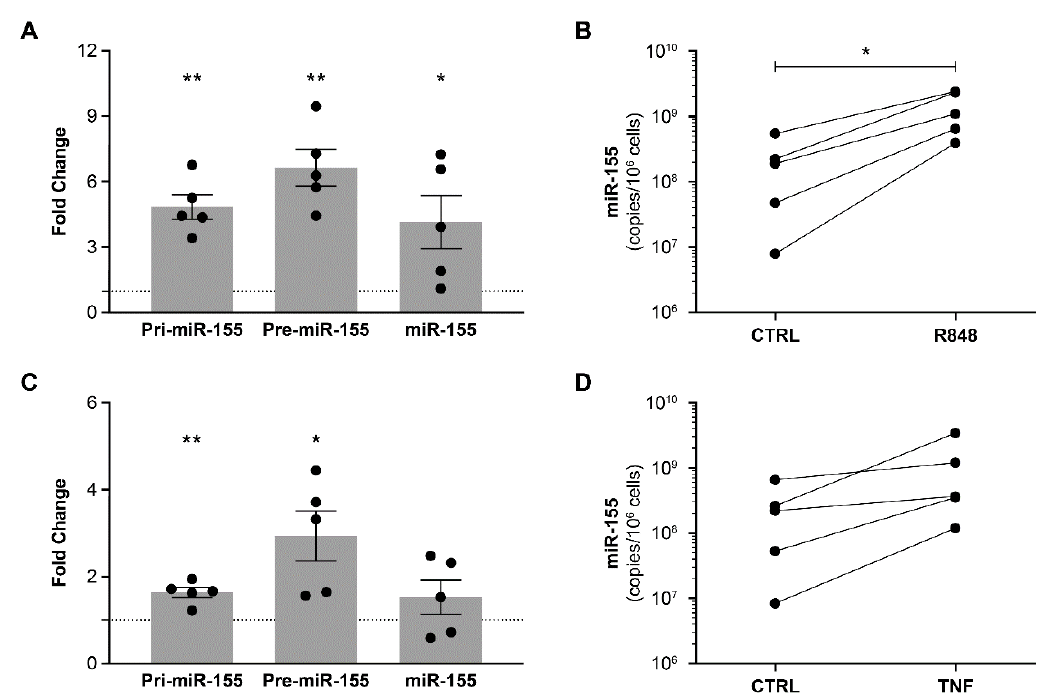
Figure 2. TLR7/8-agonist and TNF increase miR-155 expression in PBMCs. PBMCs freshly isolated from HIV-negative donors (n = 5) were incubated with ( A , B ) R848 (1 µ g/mL) and ( C , D ) TNF (100 ng/mL) for 24 h. For the fold change graphs, pri-miR-155, pre-miR-155, and miR-155 expressions by activated PBMCs are compared to their respective expression in control PBMCs, the latter represented by the dotted line in the graph positioned at y = 1. Significant difference (* p < 0.05; ** p < 0.01) is based on parametric paired t-tests to compare the expression of a gene in activated PBMCs versus the expression of the same gene in control PBMCs. Expression levels were measured by RT-qPCR. Fold change in expression level was calculated as 2 - ΔΔ Ct with PPIA as the control gene. Concentrations were calculated from a standard curve produced using synthetic miR-155. Each dot represents one donor. Significant difference (* p < 0.05) is based on parametric paired t-tests.